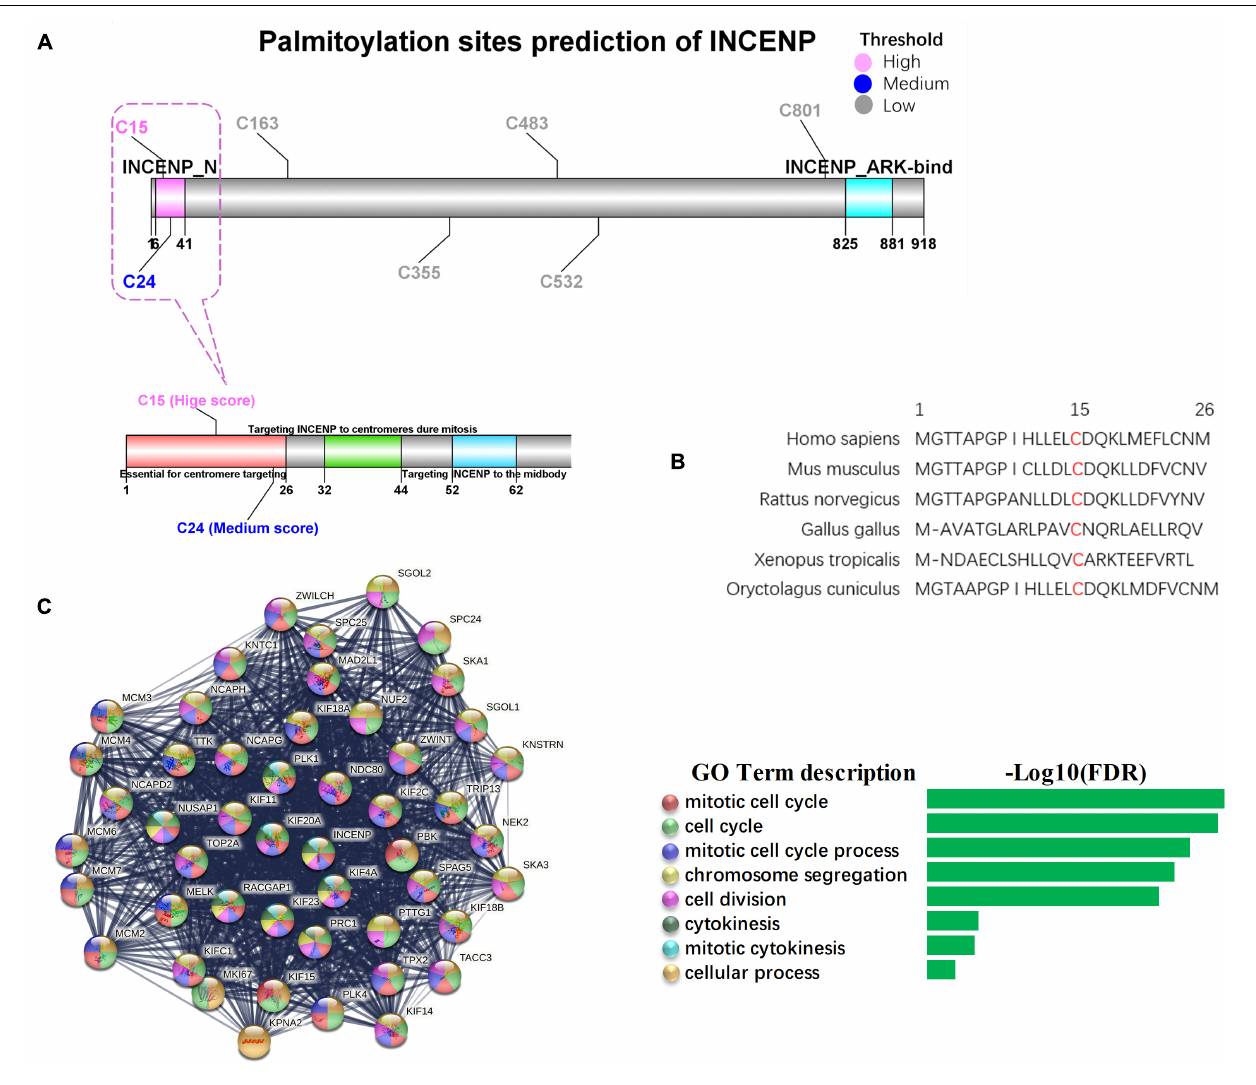
FIGURE 4 | Palmitoylation sites of INCENP and its function in cancer stem cell. (A) The palmitoylation sites prediction for INCENP was performed by CCS-Palm 4.0, with the INCENP protein sequence. Cysteine, Cys, C. The color presents high (pink), medium (blue) and low (blue) palmitoylation score, respectively. The significant domains were marked pink (6-41, INCENP_N), and blue (825-881, INCENP ARK-bind). The region surrounding Cys 15 is shown in detail (bottom). (B) The first 26 amino acid sequences of the INCENP across species. (C) PPI networks of LUAD stemness genes having direct interaction with